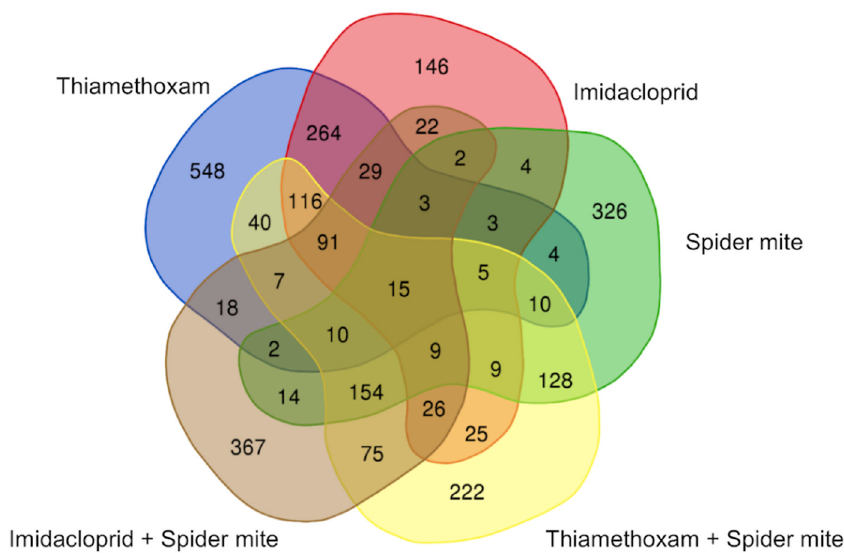
Figure 2. Venn diagram representing overlap in DEGs across treatments and DEGs unique to each of the treatments. DEGs were compared among soybean plants exposed to thiamethoxam, imidacloprid, spider mites, and the combination of either neonicotinoid insecticide and spider mites. All overlapped and unique DEGs are presented in the diagram.